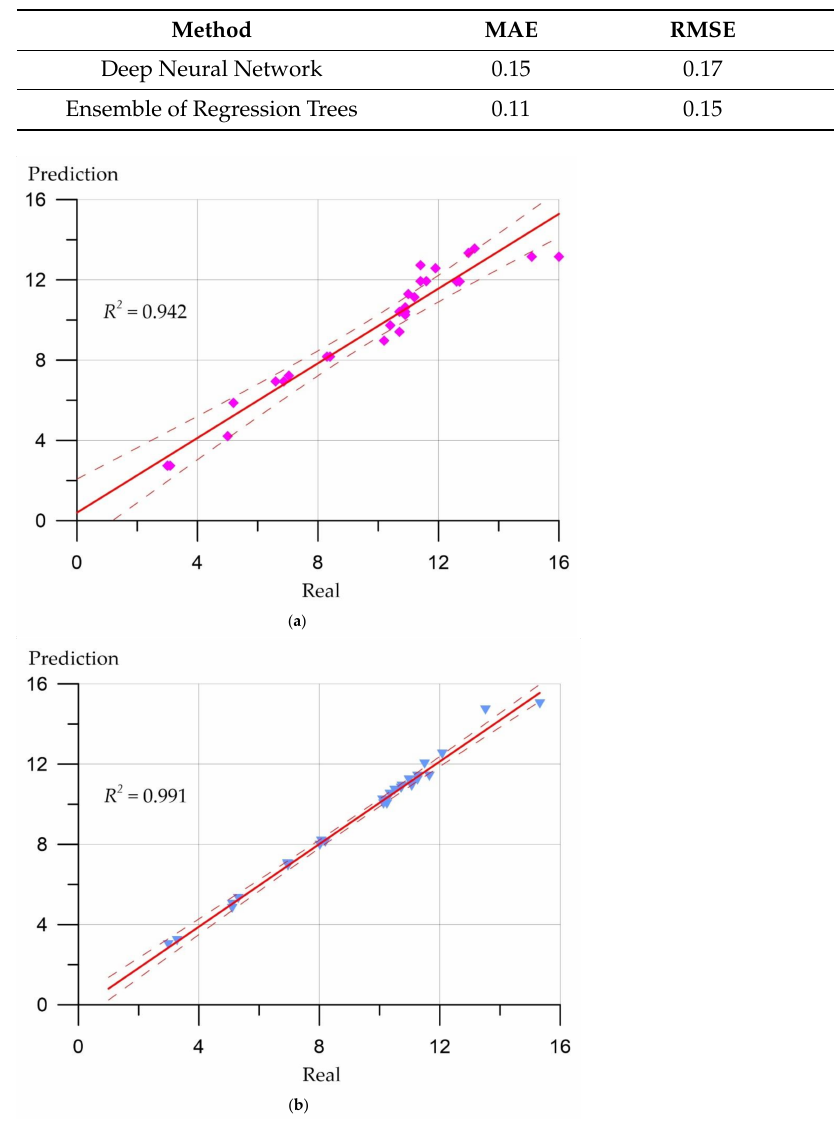
Figure 9. Correlation between real values of tensile strength in bending (MPa) and calculated values: ( a ) Deep neural network; ( b ) ensemble of regression